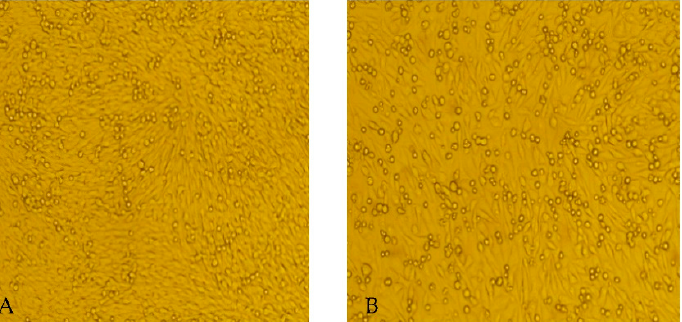
Figure 3. Cytopathic effects (CPEs) of the SXYQ1944-2 virus isolate on BHK-21 cells. Note: ( A ) BHK-21 cells cultured for 3 days under standard conditions. ( B ) BHK-21 cells 3 days after inoculation with ground sandfly supernatant containing the SXYQ1944-2 virus isolate. Compared with the BHK-21 cultures in ( A ), those in ( B ) had fewer adherent cells and more shrunken and exfoliated cells. 200 × magnification.